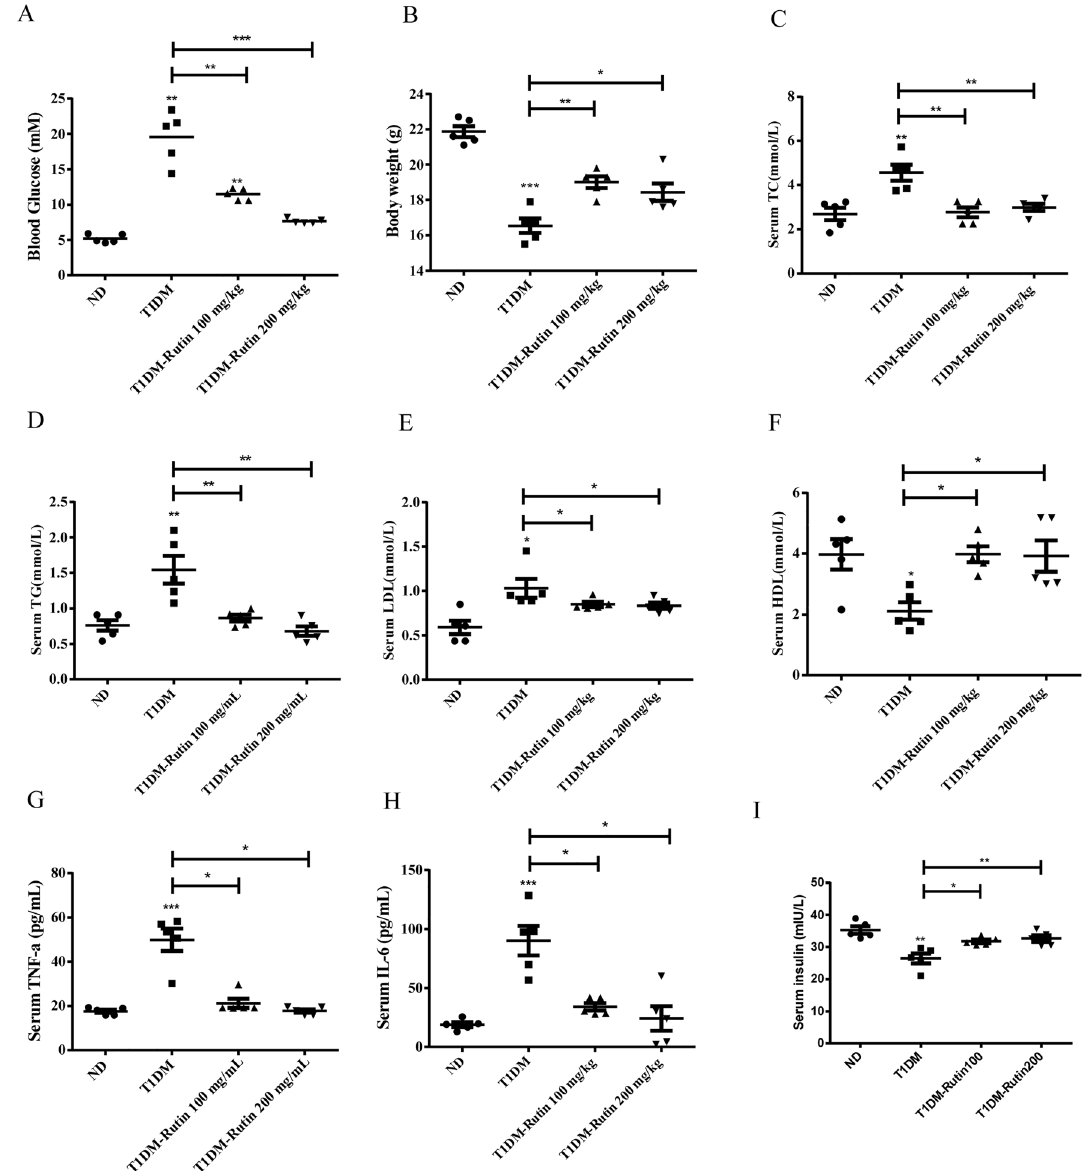
Figure 1. Effects of rutin on serum glucose and lipids in STZ-induced diabetic mice. ( A ) Fasting serum glucose. ( B–I ) Serum TC, TG, LDL-C, HDL-C, TNF-α, IL-6, and insulin levels. Values are means ± SD (n = 5): *p < 0.05, **p < 0.01, ***p <